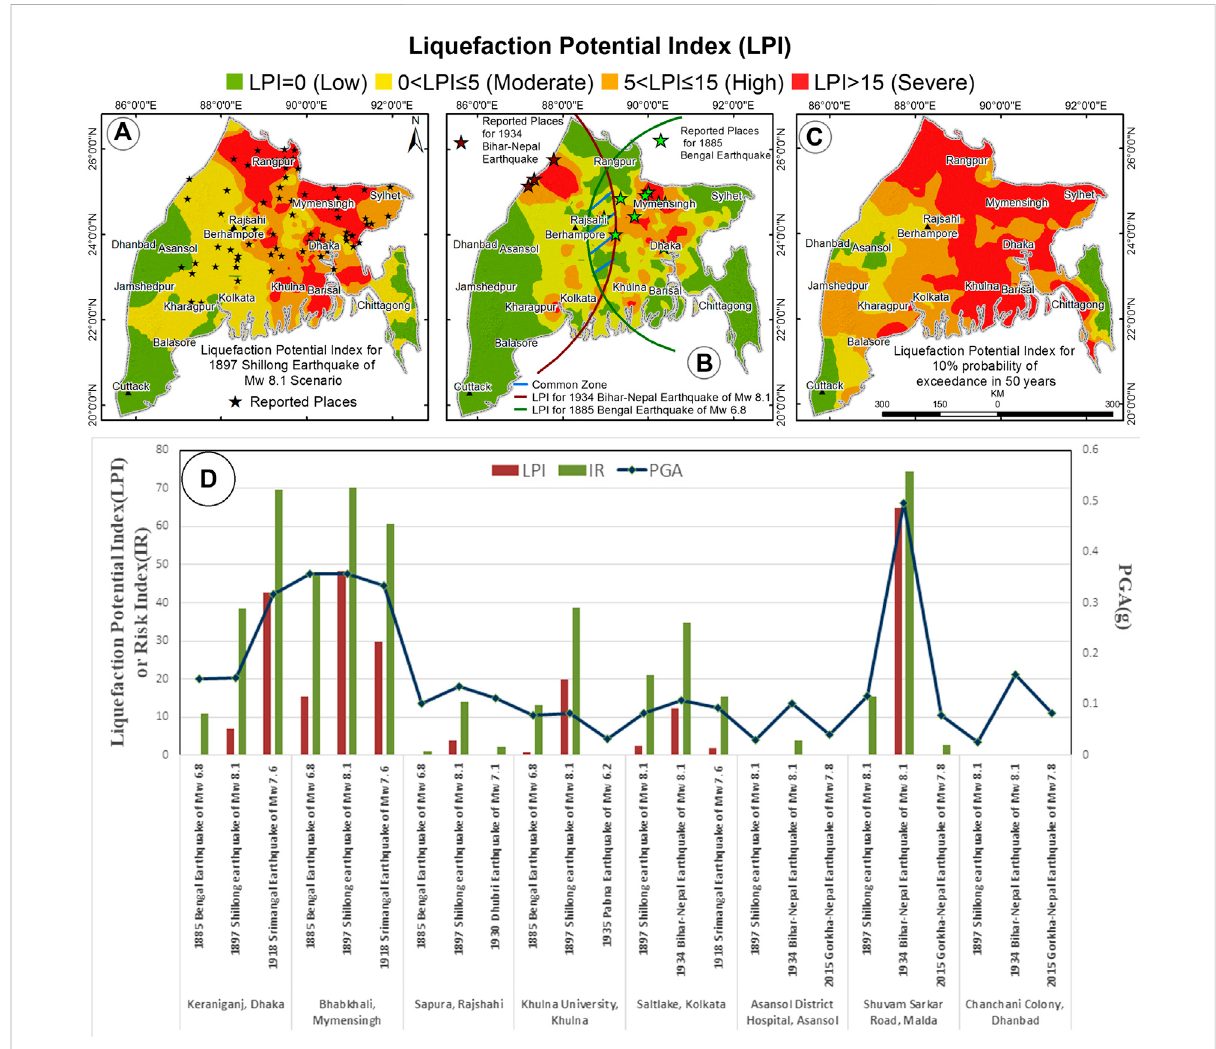
FIGURE 10 Spatial distribution of the liquefaction potential index for the scenario earthquakes of (A) 1897 Shillong earthquake for the entire basin, (B) 1885Bengalearthquakefortheeasternsideofthebasin,1934Bihar – Nepalearthquakeforthewesternsideofthebasin, (C) probabilisticscenariofor the region along with (D) liquefaction potential index, liquefaction risk index, and corresponding PGA values of the few representative sites of the cities of Dhaka, Mymensingh, Rajshahi, Khulna, Kolkata, Asansol, Malda, and